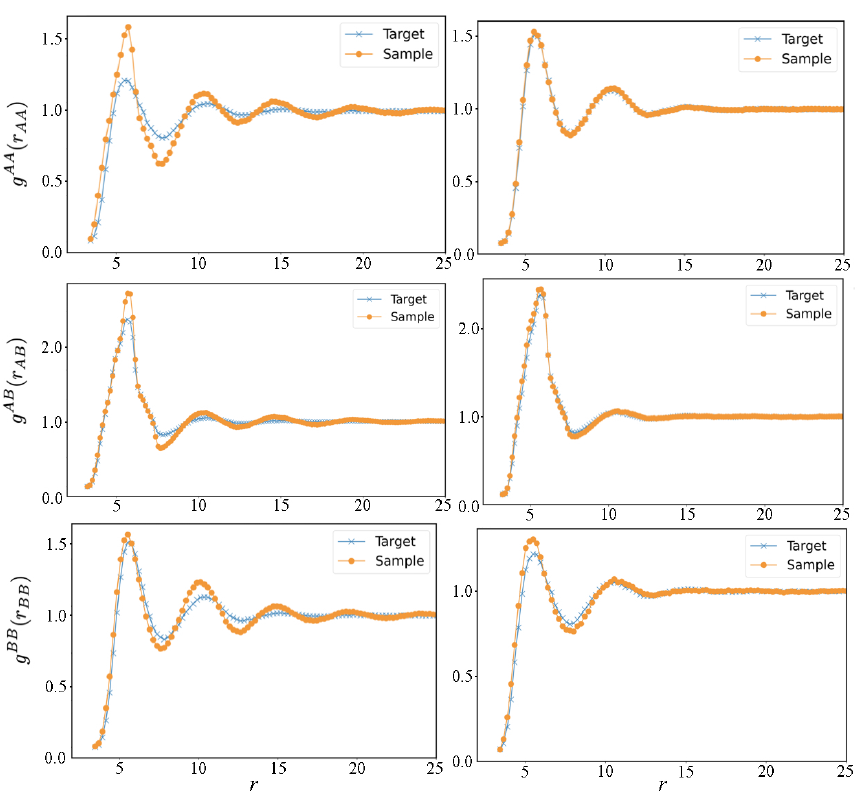
Figure 2. Long-range radial distributions obtained in all-atoms simulations, compared to the coarse- grained ones (distance in Å). In the left panels, the coarse-grained distributions in the first step of the IBI procedure are reported, and the right panels report the distributions in the final iteration.